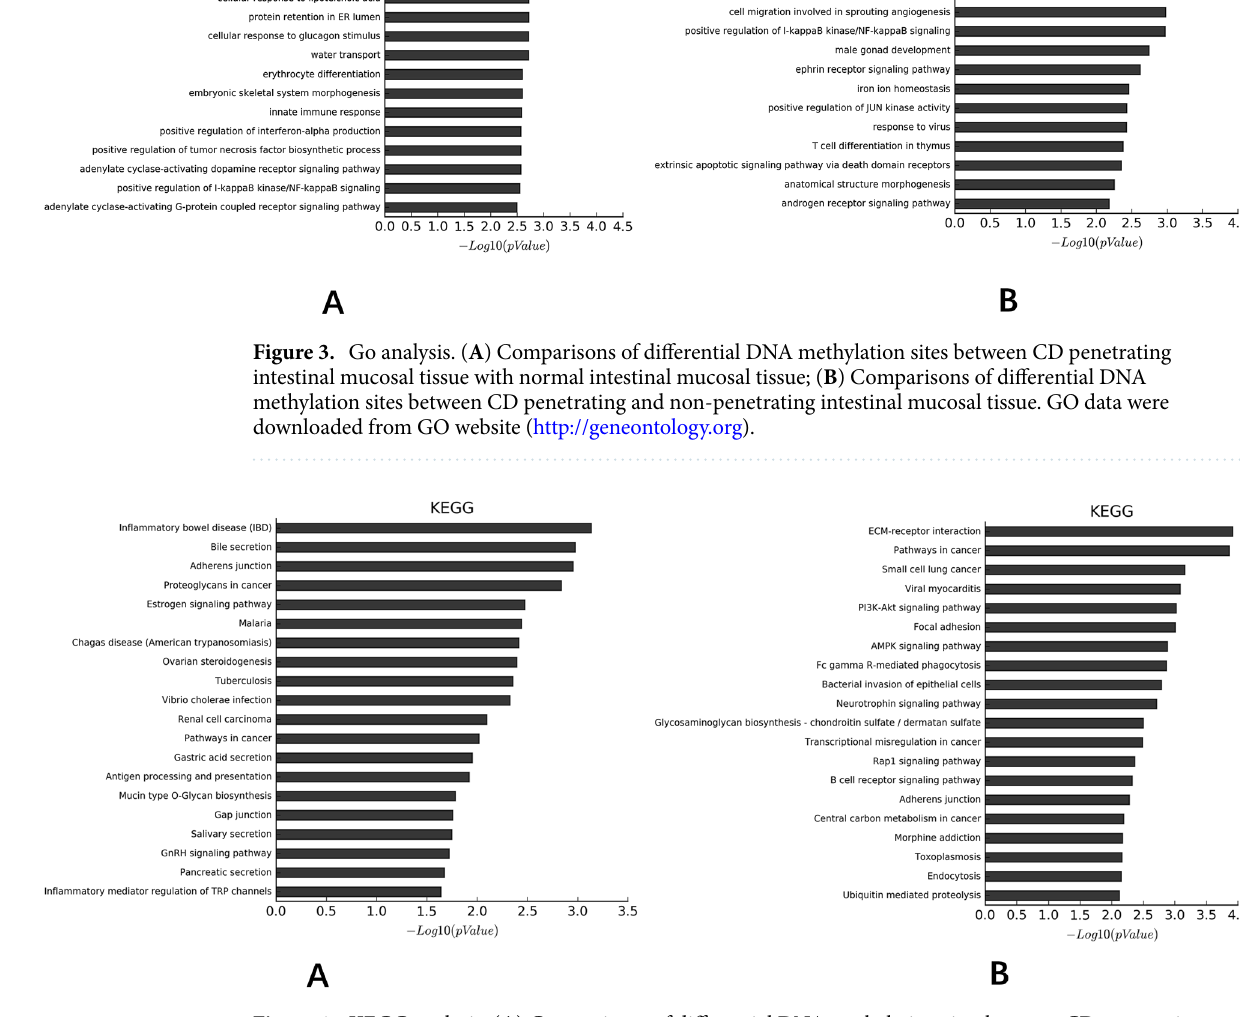
Figure 4. KEGG analysis. ( A ) Comparisons of differential DNA methylation sites between CD penetrating intestinal mucosal tissue with normal intestinal mucosal tissue; ( B ) Comparisons of differential DNA methylation sites between CD penetrating and non-penetrating intestinal mucosal tissue. KEGG pathways were downloaded from KEGG website (https:// www. kegg. jp). The permission was provided by Kanehisa Correlation between methylation abnormality degrees and gene expression levels. According to the correlation analysis (Fig. 5C), the methylation abnormality degrees of HLA-DRB1 (r = − 0.62, P < 0.001), MUC1 (r = − 0.45, P = 0.01), YPEL5 (r = − 0.55, P = 0.001) and CBLB (r = − 0.62, P < 0.001) were found to have significant negative correlations with their relative expression levels in the intestinal mucosal tissue in CD group and control group. Correlation between methylation degree of MUC1 and disease activity of CD. The CDAI scores of CD group were evaluated and calculated on the day of sampling. Through correlation analysis (Fig. 5D), methylation abnormality degree of MUC1 in the intestinal mucosa of CD group was negatively correlated with the cor- responding CDAI scores (r = 0.50, P = 0.01), while methylation abnormality degrees of HLA-DRB1 (r = 0.02, P = 0.91), YPEL5 (r = 0.33, P = 0.11) and CBLB (r = 0.08, P = 0.71) were not correlated with CDAI scores. The fold changes of DEGs among GSE95095, GSE83448, GSE103027 and GSE102133. Heat maps were gener- ated to visualize the fold changes (FC) of expressed genes between CD and normal controls from different studies. As shown in Fig. 6, heat maps were generated with R based on the FC of selected DEGs (HLA-DRB1,